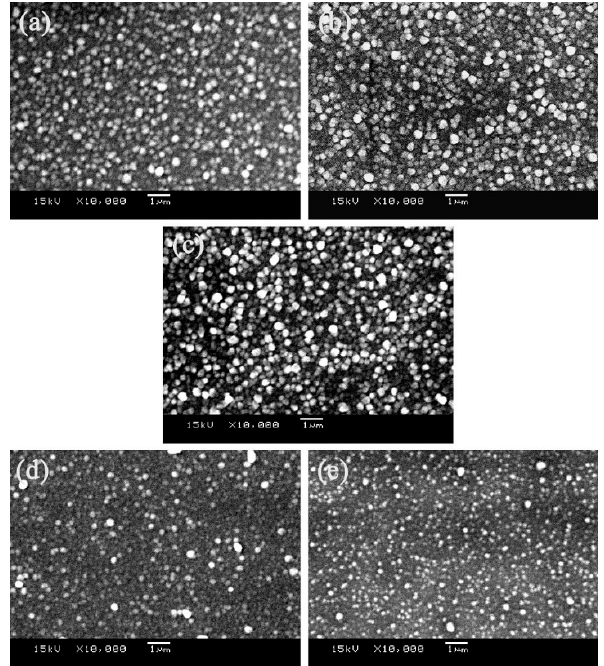
Figure 3. SEM patterns of the InN thin films deposited at ( a ) 200 ° C , ( b ) 300 ° C , ( c ) 400 ° C , ( d ) 500 ° C and ( e ) 600 °C .